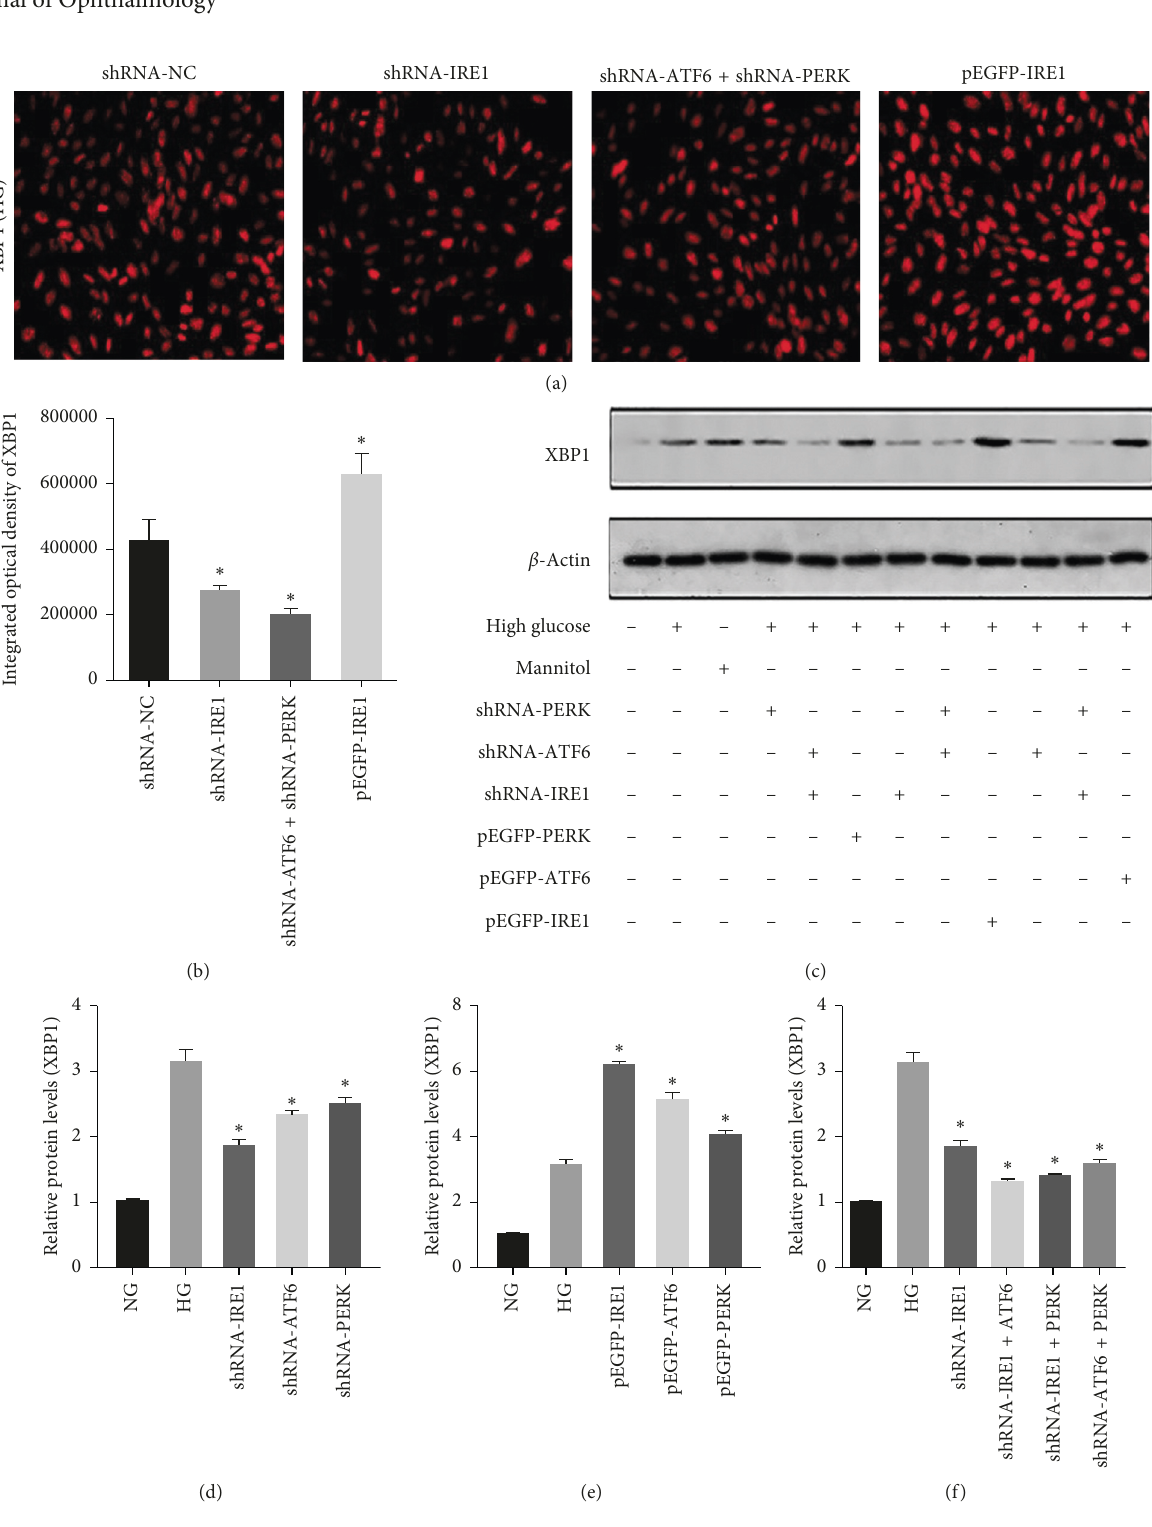
Figure 5: Immunofluorescence and immunoblotting of XBP1 in rMCs at HG. (a, b) Suppression of UPR pathways significantly decreased XBP1 immunofluorescence. (c–f) The protein levels of XBP1 in rMCs transfected with PERK, ATF6, and IRE1 shRNAs or overexpression plasmids at HG for 48hours were measured by western blot analysis. The results were representative of 3 independent experiments ( n � 3; ∗ p < 0 .